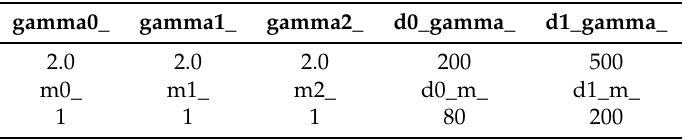
Table 4. Parameters of Nakagami